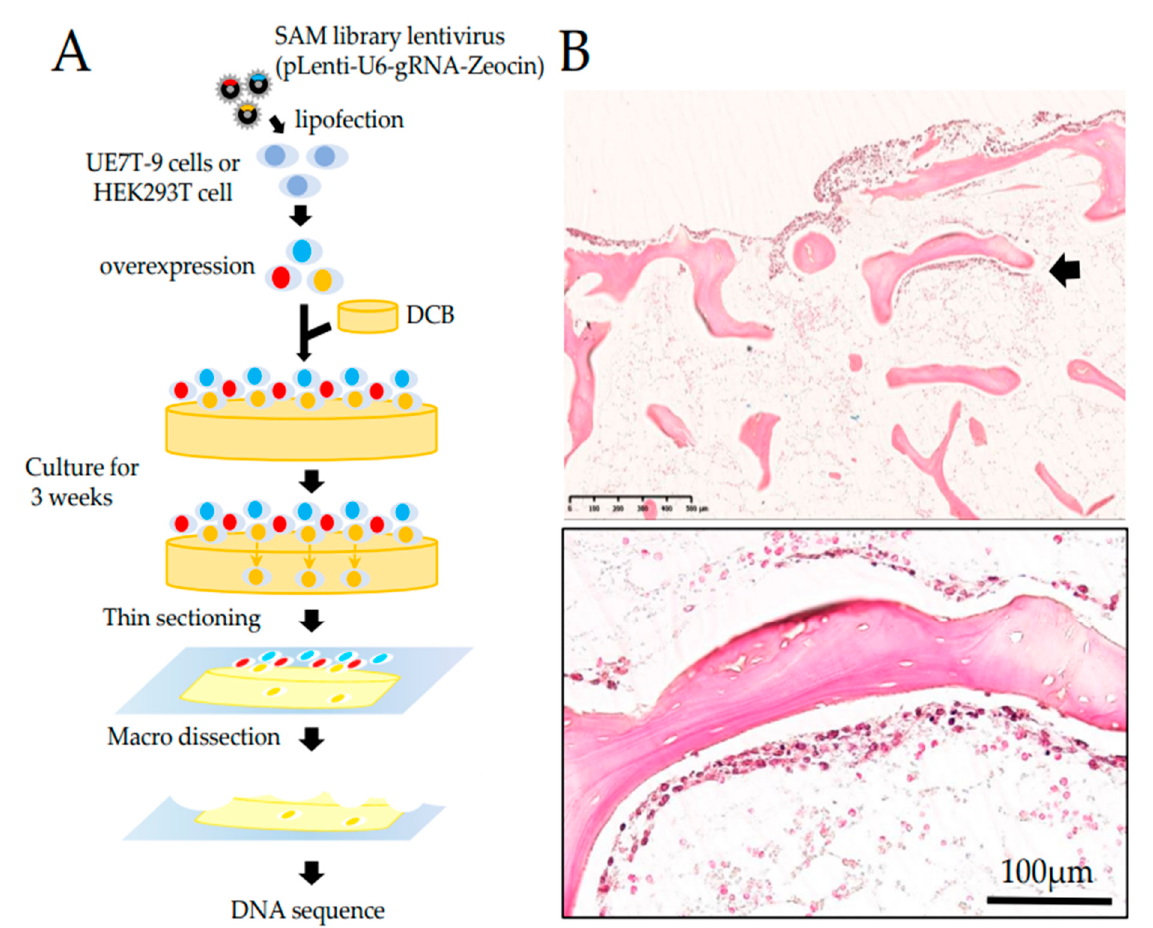
Figure 1. Finding candidate factors of intraosseous progression using CRISPR SAM library. ( A ) Schematic strategy for finding candidate factors. We introduced the CRISPR SAM library into the cell lines to randomly induce gene expression. We cultured these cells on DCB for 3 weeks and performed DNA sequencing analysis on the cellular components that infiltrated into DCB. ( B ) HE ‐ stained specimen prepared after 3 weeks of culture. The UE7T ‐ 9 cells, expressing the CRISPR ‐ SAM library, infiltrated along the bone trabeculae (black arrow). The bottom figure is a high ‐ power field of the above.